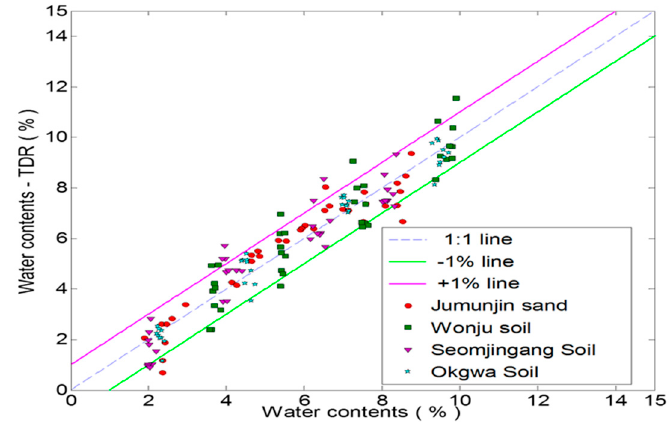
Figure 19. Moisture content measured by flat type TDR and standard test.